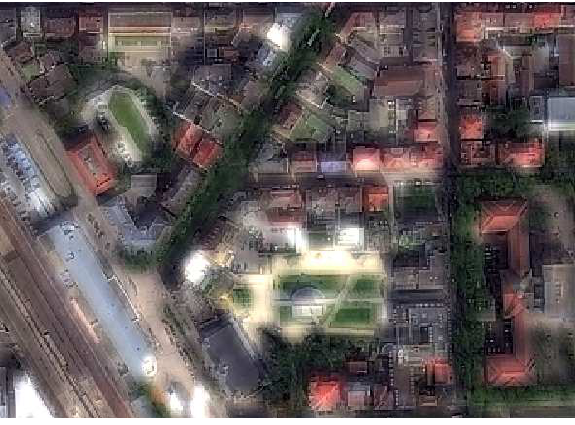
Figure 5: RGB channels of the Wavelet Fusion image